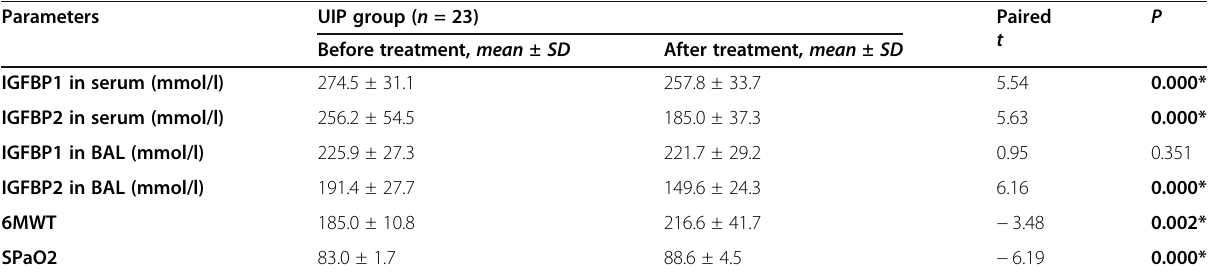
Table 3 Comparison between UIP patient before and after treatment as regards IGFBP1 and IGFBP2 in both serum and BAL, 6MWT, and